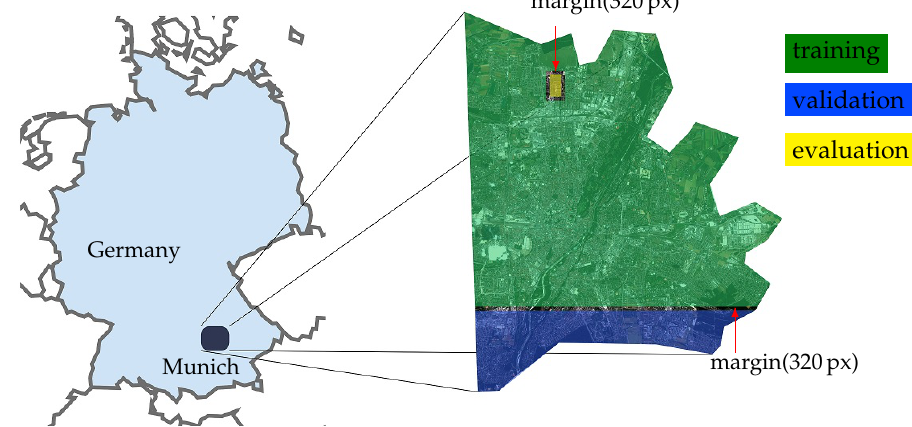
Figure 3. AOI of Munich, Germany. The AOI is further tiled into datasets for training, validation and evaluation. Between the datasets we left a margin of 320px to prevent data